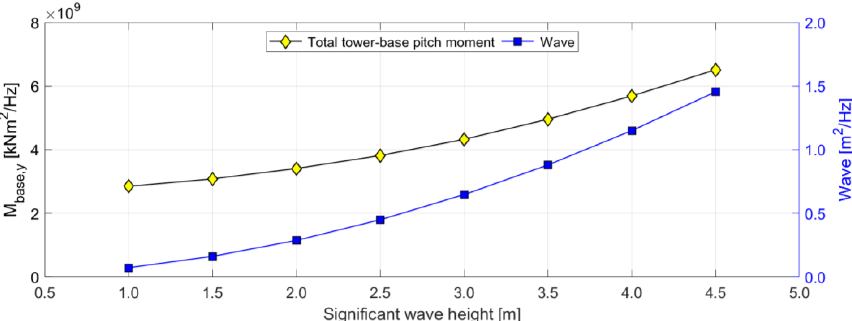
Figure 12. Total tower-base pitch moment and wave spectral energy per significant wave height.